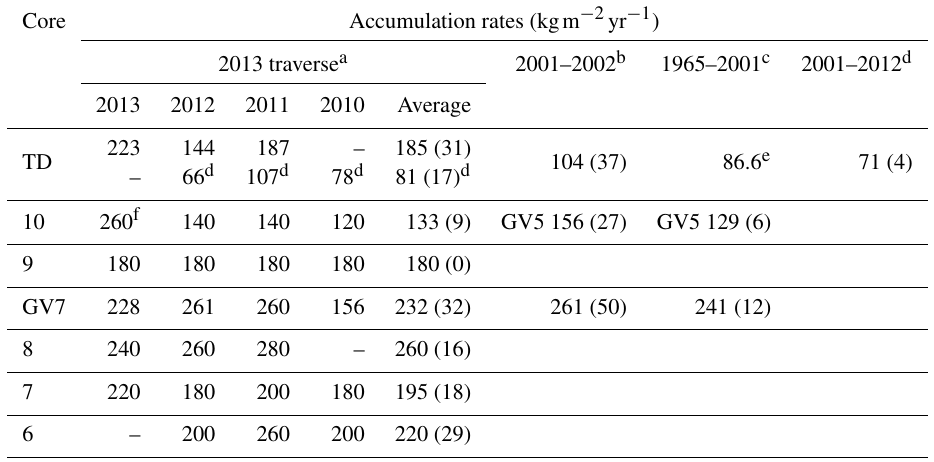
Table 2. Summary of accumulation rate data from northern Victoria Land. All uncertainties (shown in parentheses) are 1 σ